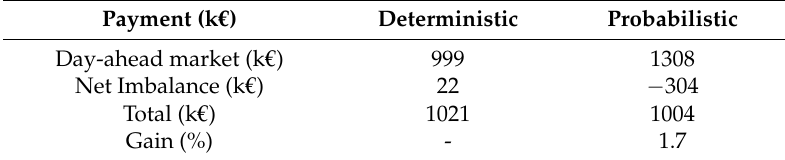
Table 4. Aggregator annual payment from the participation only in the Day-ahead (DA) market.